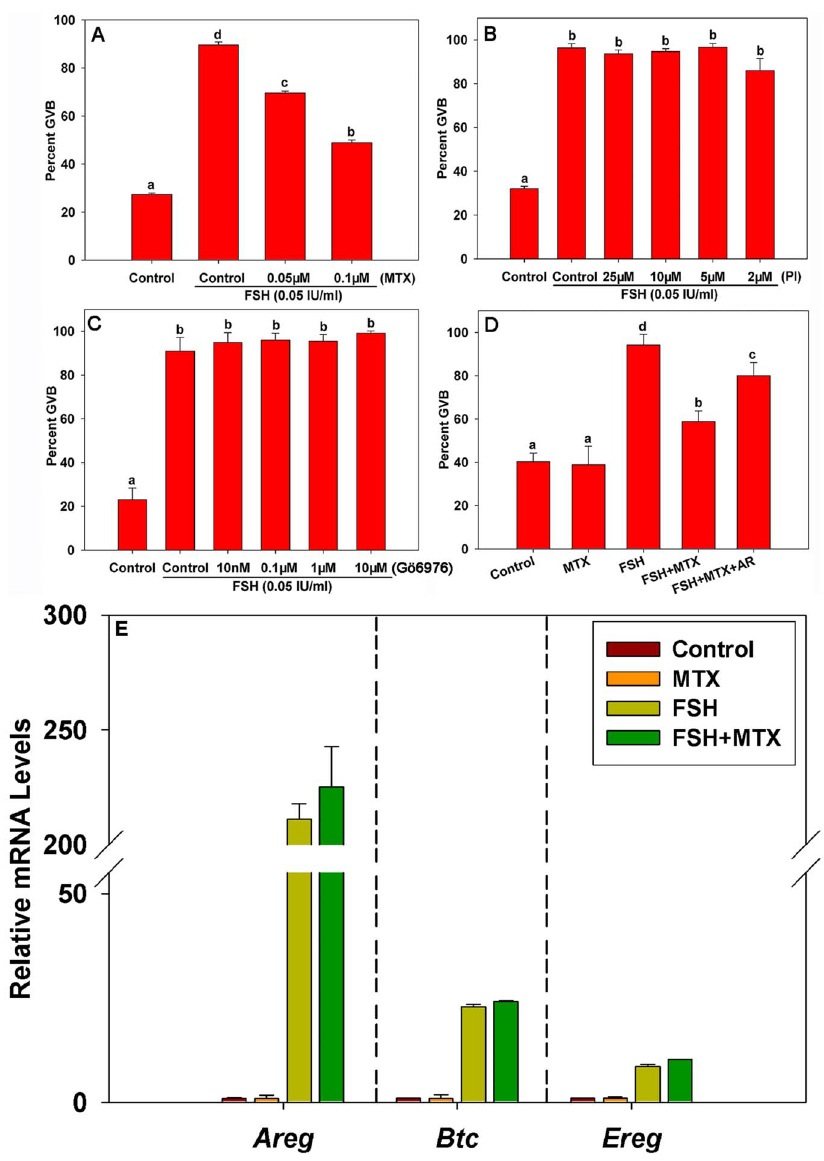
Figure 1. The effect of Areg on PKC d - and h -mediated FSH-induced meiotic resumption in COCs. The germinal vesicle breakdown (GVB) ratio of COCs cultured in FSH-supplemented media with or without the PKC d and h inhibitor rottlerin (MTX) ( A ), PKC f pseudosubstrate inhibitor (PI) ( B ), or PKC a and b I inhibitor Go¨6976 ( C ) for 22–24 h. The GVB ratio of COCs cultured in media supplemented with either 0.1 m M MTX, 0.05 IU/mL FSH, MTX plus FSH, or MTX plus FSH plus 100 ng/mL Areg for 22–24 h ( D ). After COCs were cultured in media with either FSH (0.05 IU/mL) and/or 0.1 m M MTX for 4 h, the mRNA levels of Areg , Ereg and Btc in cumulus cells were detected using real-time PCR ( E ). Letters (a–d) on different columns in each chart indicate significant difference between groups ( p , 0.05). AR: